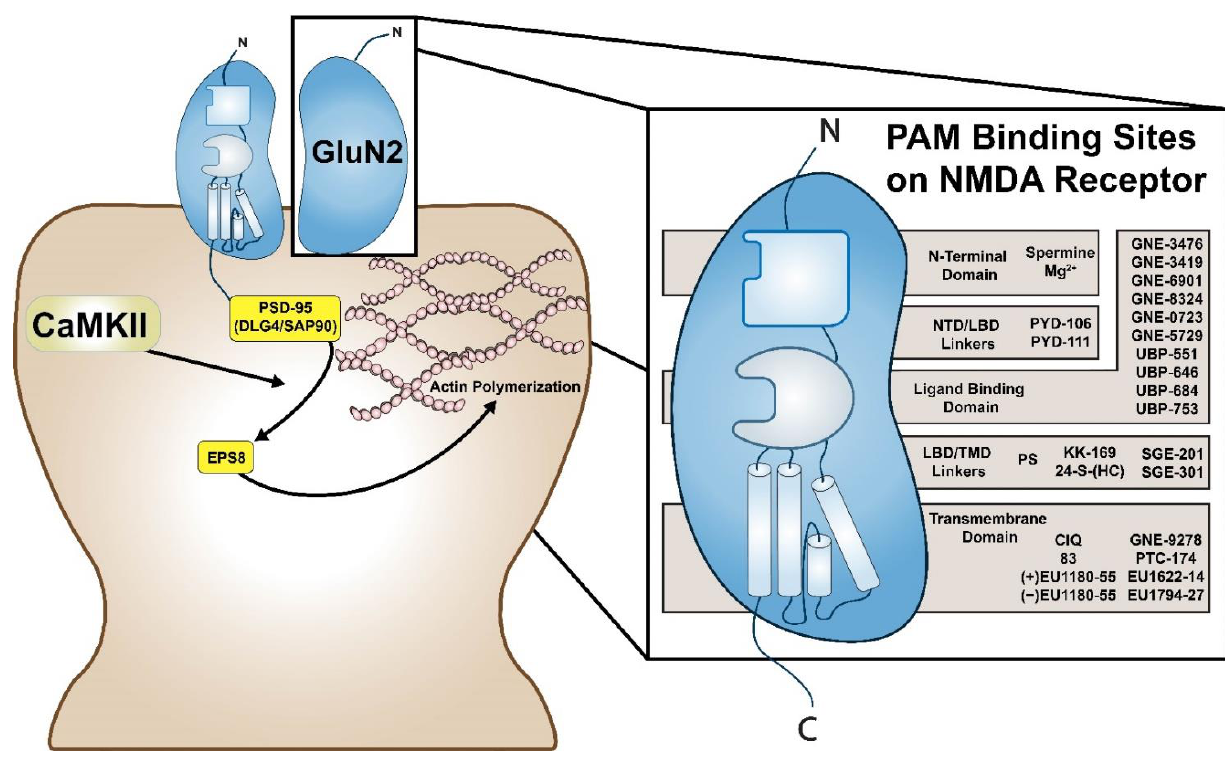
Figure 1. Intracellular signaling and allosteric modulatory binding sites on the NMDA receptor.